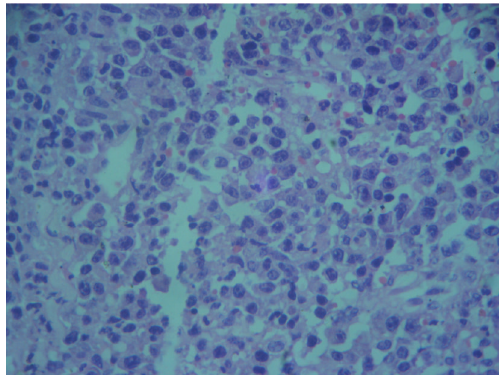
Figure 3: Di ff use large lymphoid cells with abundant eosinophilic cytoplasm, centrally or few eccentrically placed nuclei, and pleo- morphic basophilic nucleoli ( ×